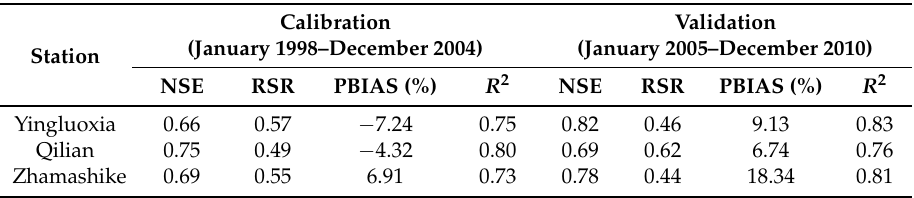
Table 6. Evaluation of runoff